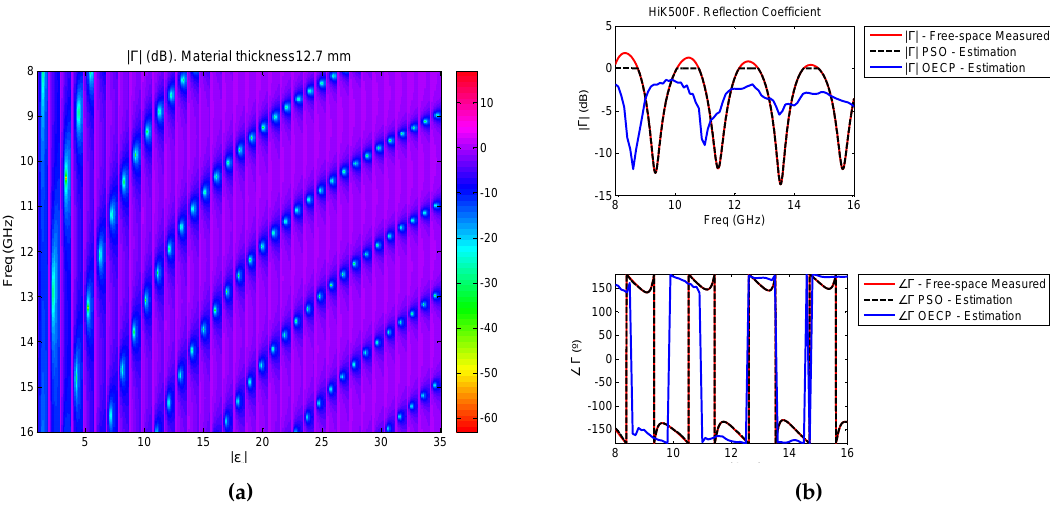
Figure 8. Reflection coefficients: ( a ) theoretic reflection coefficient of a short-circuited material of thickness 12.7 mm according to different values of permittivity ( b ) measured and estimated reflection coefficients for material Eccostock HiK500F, module and